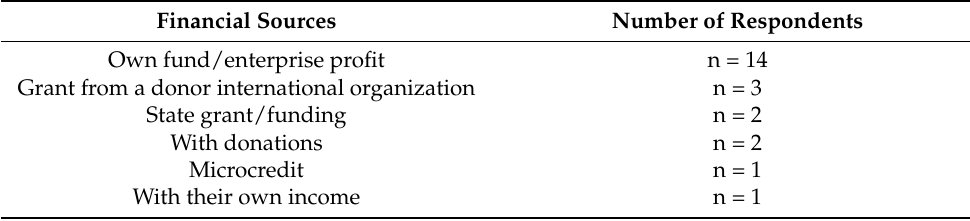
Table 3. Current sources of funding for social